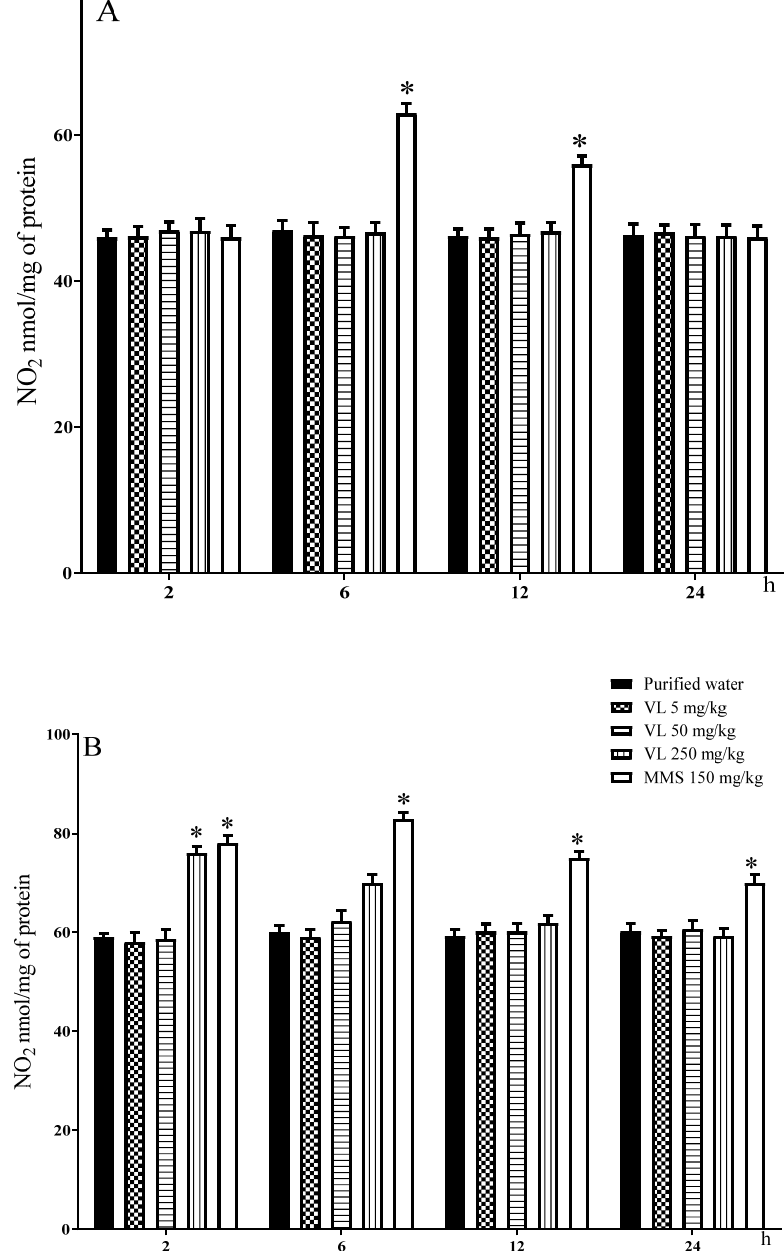
Figure 5. Effect of venlafaxine (VL) on the nitrite content (NO 2 ) in the brain of mouse ( A ) and in mouse hepatic tissue ( B ). MMS = methyl methanesulfonate. Each bar represents the average ± SDM found in 5 separated observations per dose. * Shows statistically significant difference in comparison with the control level. Two-way ANOVA and Tukey tests ( p ≤ 0.05).